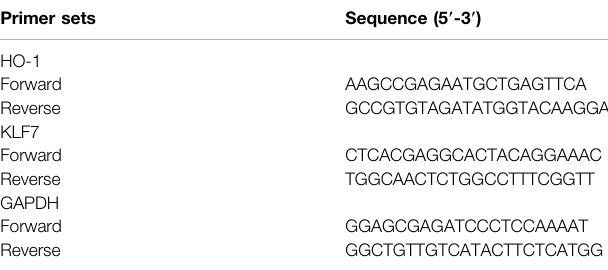
TABLE 1 | Primer sets for qPCR assay.